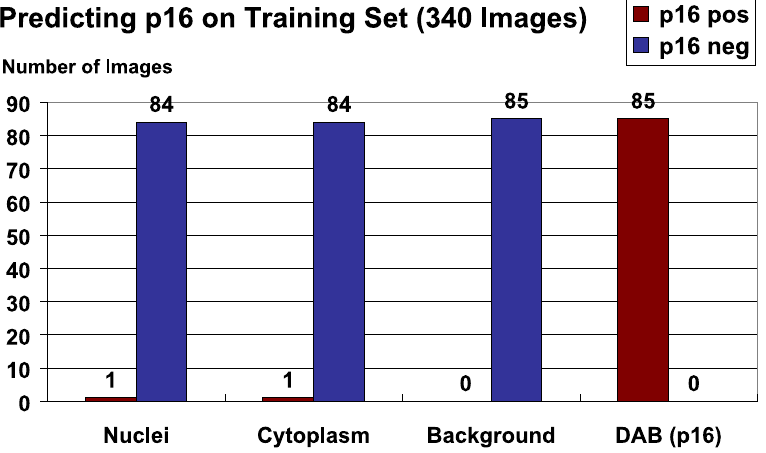
Fig. 5. Training data set. Classification of all images from the training data set for p16-positive objects when applying the ranges resulting from the HSV color space analysis. All 85 training images containing p16-stained cells were recognized. One of 85 nuclei images and one of 85 cytoplasm images but no background images were rated